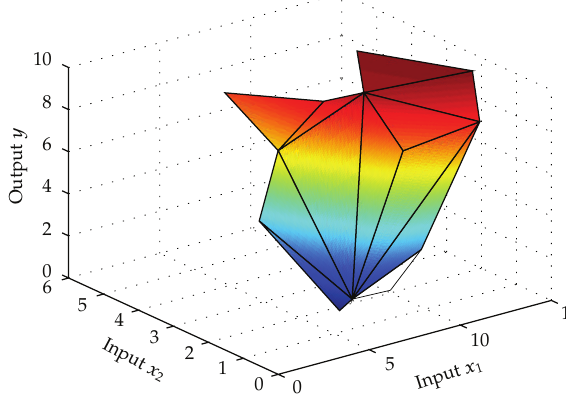
Figure 6: Fully e ffi cient hull,